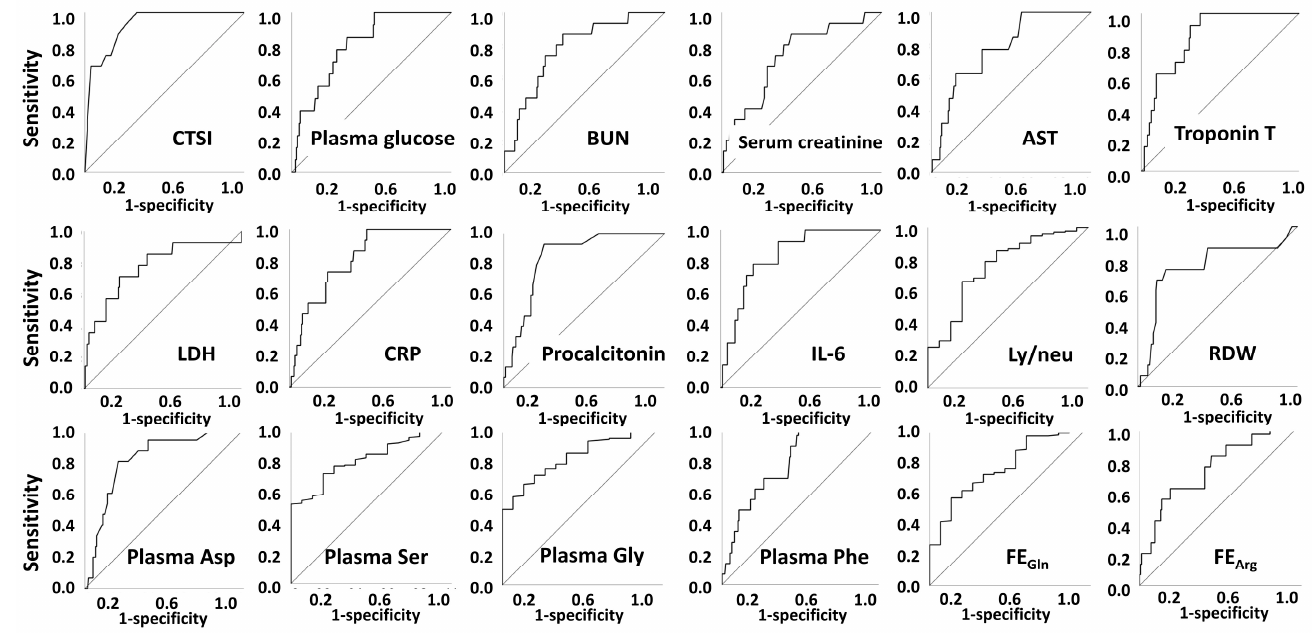
Figure 2. ROC curves of parameters with area under the ROC curve above 0.700 for mechanical ventilation. Abbreviations: CTSI, CT severity index; BUN, blood urea nitrogen; eGFR, estimated glomerular filtration rate; AST, aspartate transaminase; LDH, lactate dehydrogenase; hsCRP, high-sensitivity C-reactive protein; IL-6, interleukin 6; WBC, white blood cell; RDW, red blood cell distribution width; Ly/neu, lymphocyte/neutrophil; Neu/mo, neutrophil/monocyte; FE, fractional excretion.